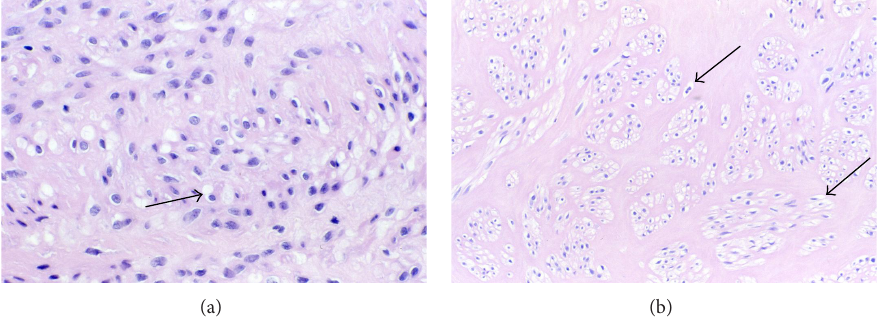
Figure 11: Vacuolization of myocytes. In Phase 3 and 4 fibroids, cytoplasmic vacuolization (arrows) is common and may reflect the loss of myofilaments and other changes related to injury or involution. As noted in both (a) and (b), the myocytes are often surrounded by an amorphous (hyaline) matrix. Original magnification of (a): 132x. Original magnification of (b): 66x.